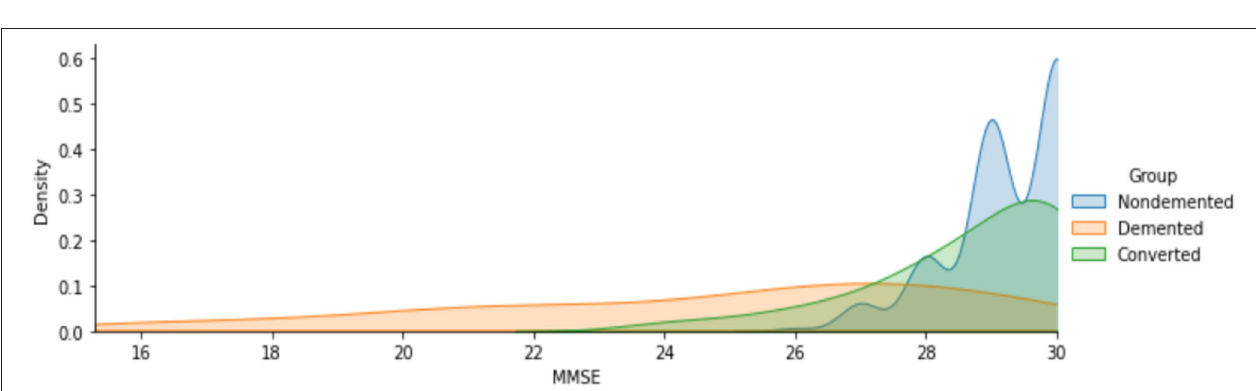
FIGURE 4 | Analysis of MMSE scores for demented and non-demented group of patients.